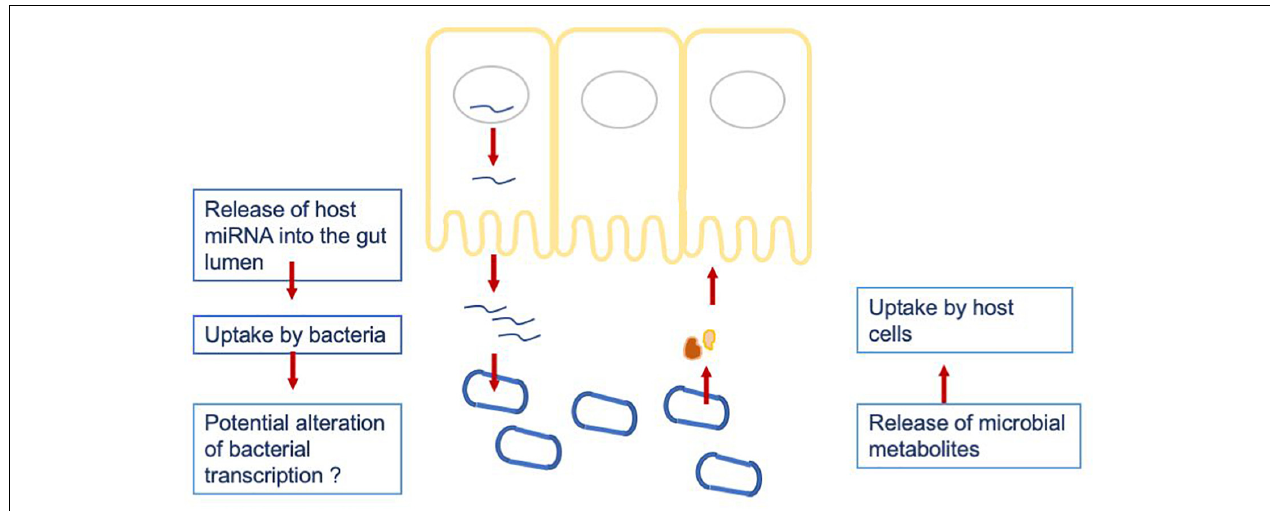
FIGURE 2 | Hypothesized crosstalk between the host miRNAs being released into the gut lumen and the gut microbiome.